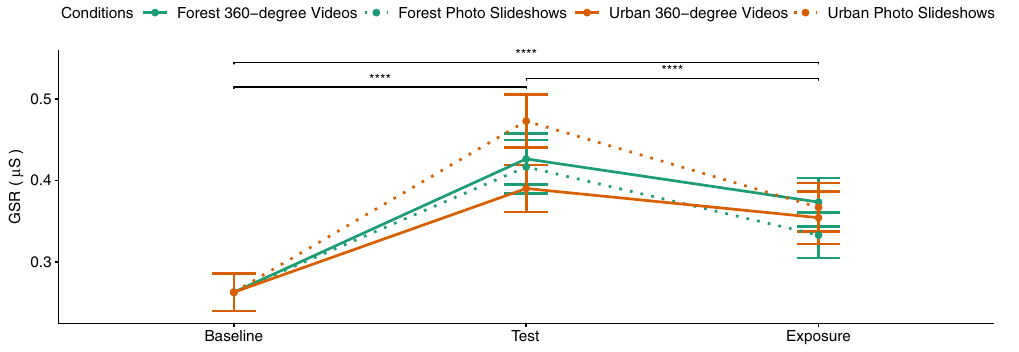
Figure 10. GSR measures during different phases of the experiment. The four conditions are distinguished by the line color (green for forest and orange for urban environment) and the line type (dotted for slideshows and ◦ solid lines for 360 videos).